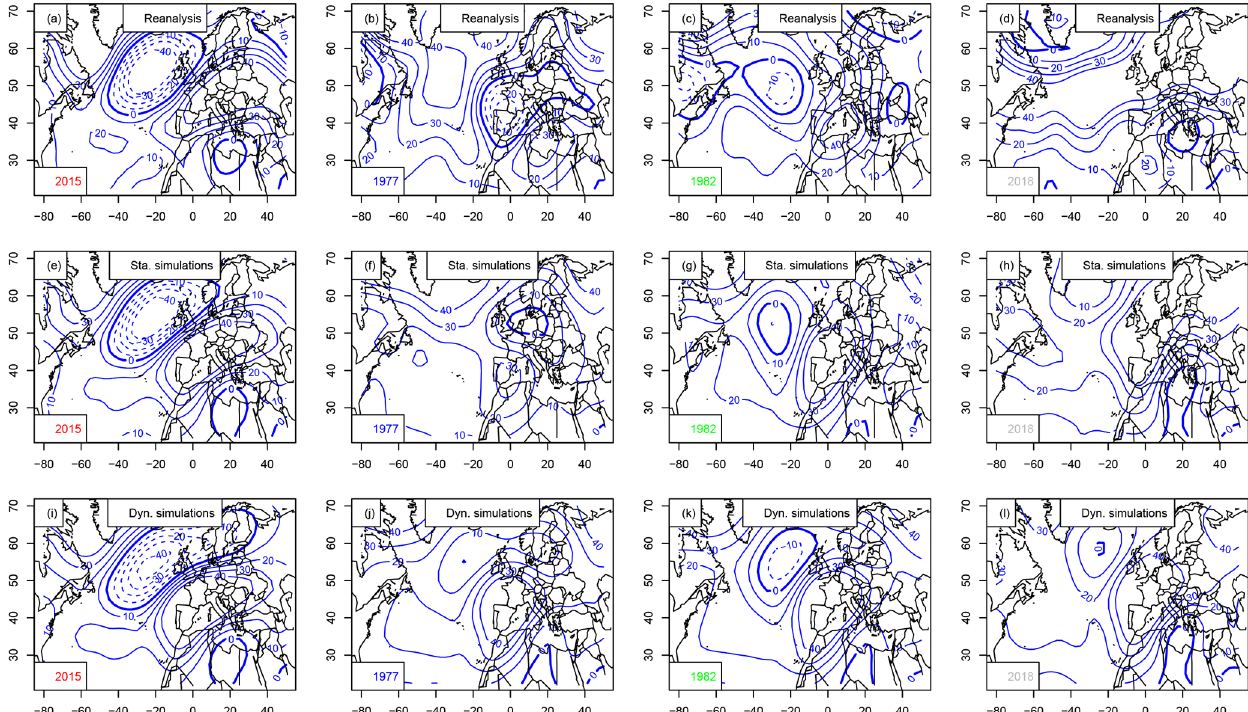
Figure C2. Z500 anomaly composites (in meters, with 10m increments) for the warmest summer in Madrid (2015), coolest (1977), median (1982) and 2018. The 0m isoline is indicated with a thick blue line. Negative anomalies are in dashed isolines. Horizontal axes are for longitudes in degrees east. Vertical axes are for latitudes in degrees north. Upper row (a–d) : mean Z500 from NCEP reanalyses. Center row (e–h) : static simulations. Bottom row (i–l) : dynamic